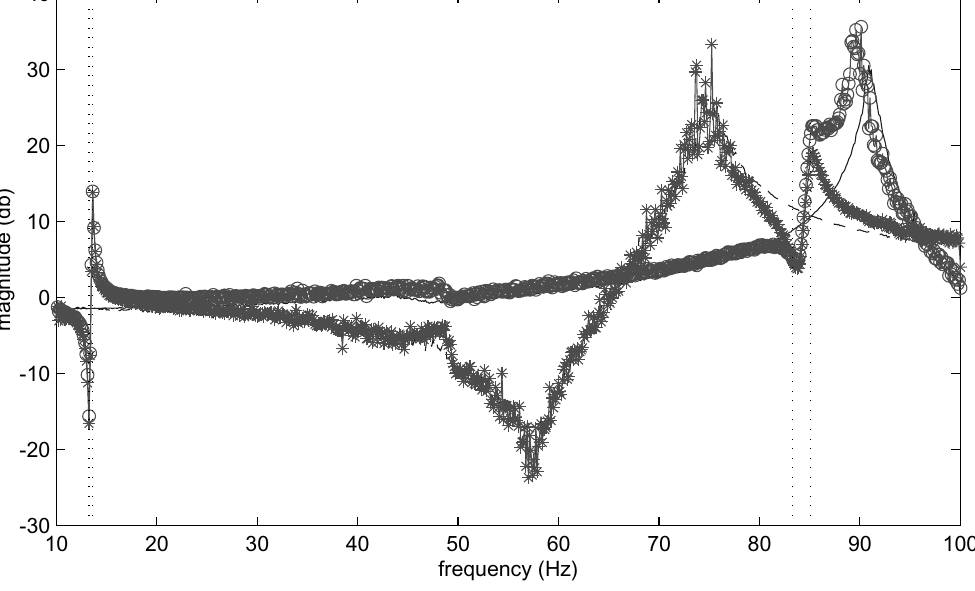
Fig. 29. Transmissibility functions for undamaged case and first loading condition (full line), undamaged case and second loading condition (dashed line), damaged case and first loading condition (full line with o) damaged case and second loading condition (full line with